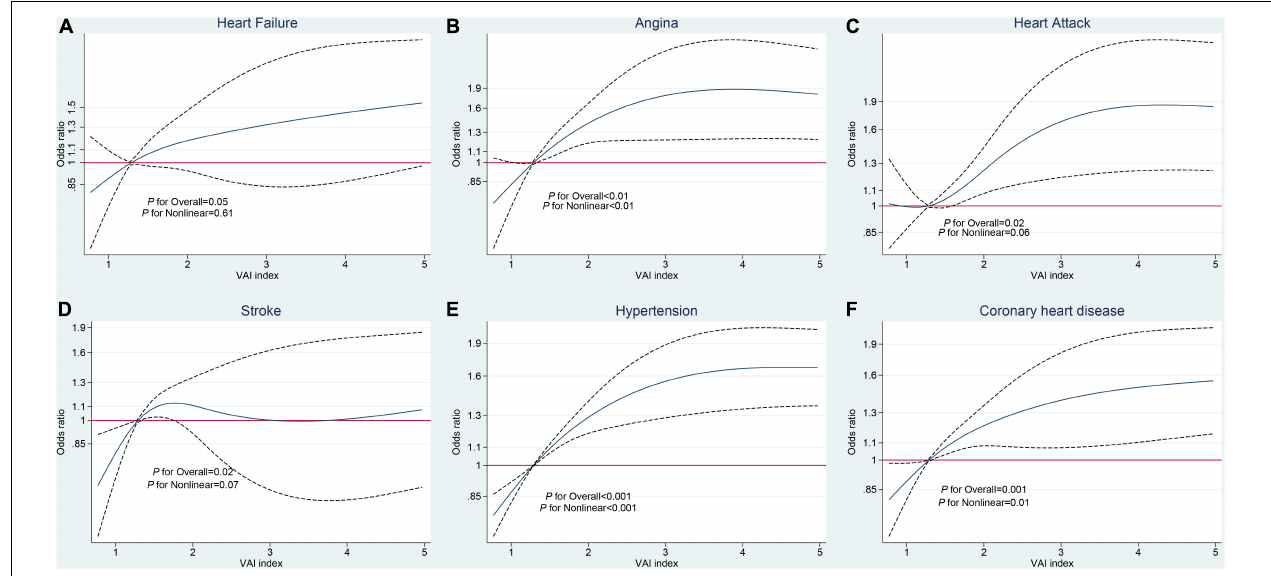
FIGURE 2 | Restricted cubic spline analysis of the relationships between visceral adiposity index (VAI) and cardiovascular and cerebrovascular diseases (CCDs). (A) Heart failure. (B) Angina. (C) Heart attack. (D) Stroke. (E) Hypertension. (F) Coronary heart disease.